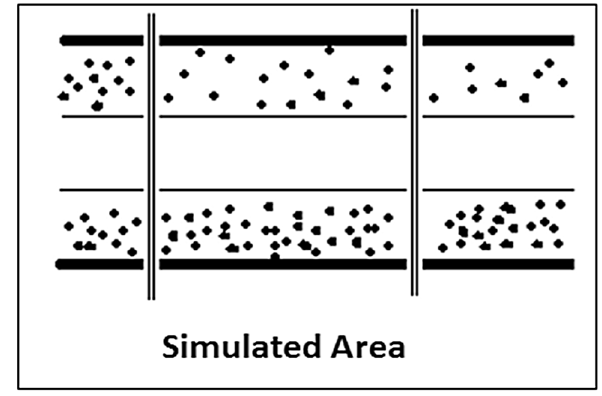
Fig. 1 Wellbore simulated area